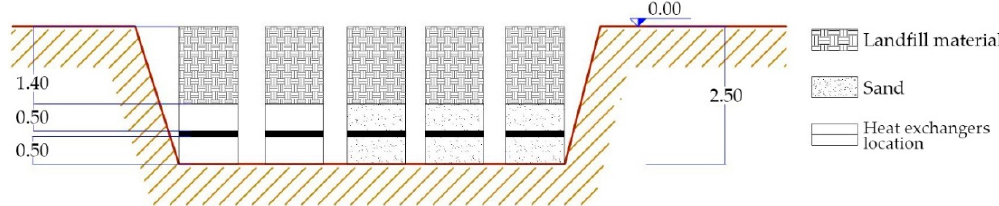
Figure5. Figure 5. Sandwich configuration of the ground lodging the slinky ground source heat exchangers (GHEXs).